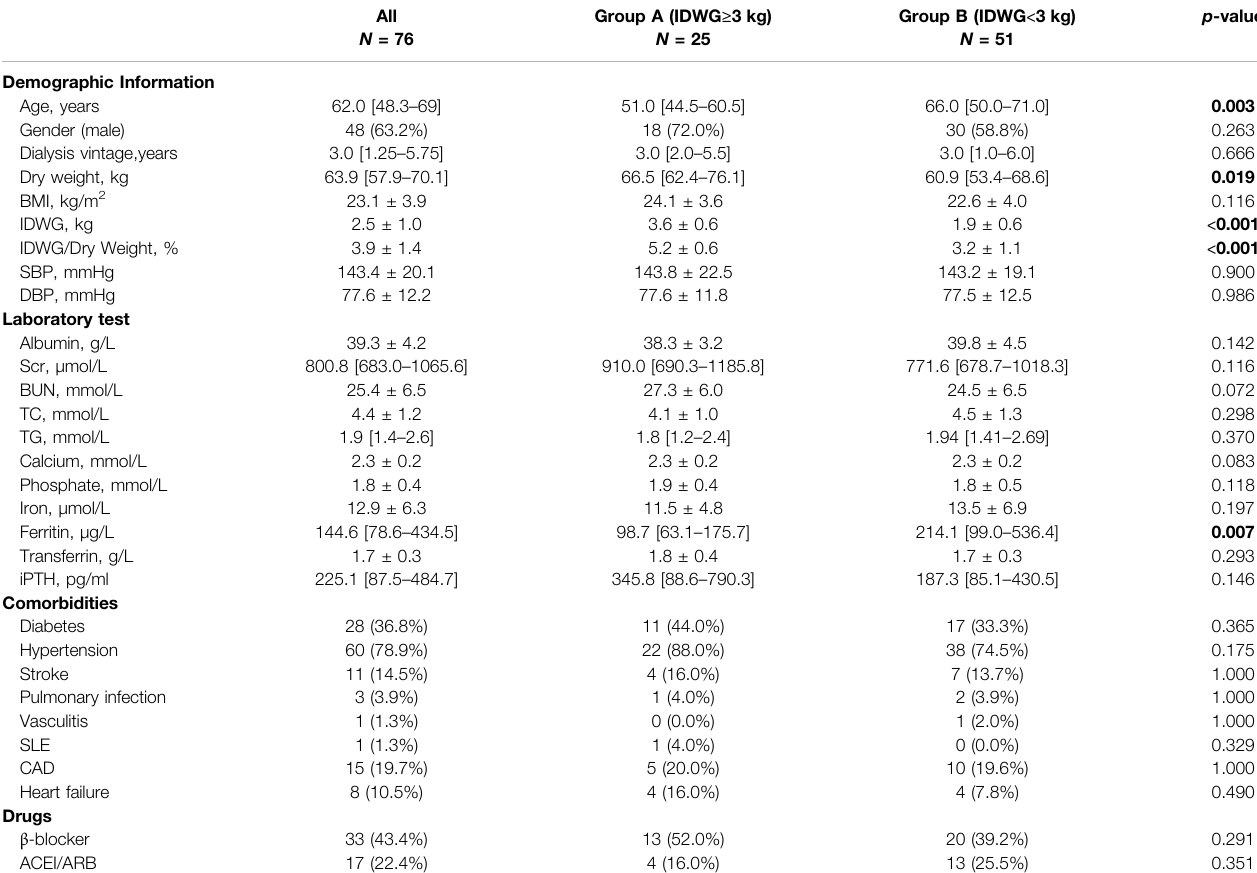
TABLE 1 | Baseline characteristics of HD